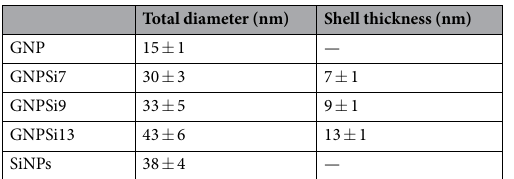
Table 1. Average total particle diameter and silica shell thicknesses obtained by TEM for gold nanoparticles (GNP), silica-coated gold nanoparticles (GNPSi7, GNPSi9 and GNPSi13) and silica nanoparticles (SiNPs).